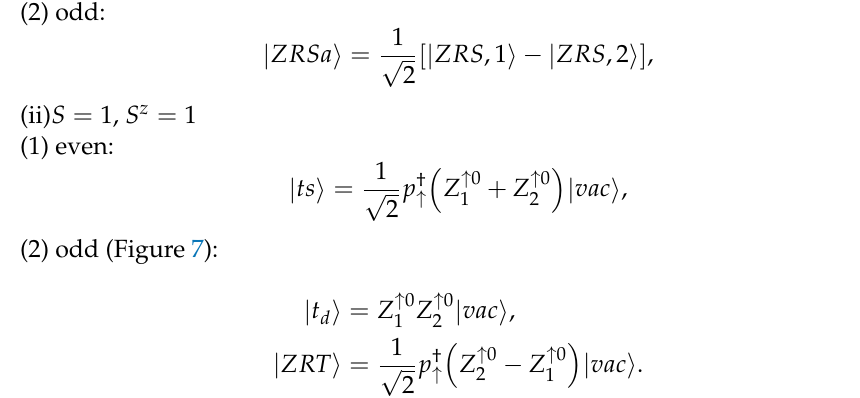
Figure 6. Scheme of | s d (cid:105) , | ZRS 1 (cid:105) , and